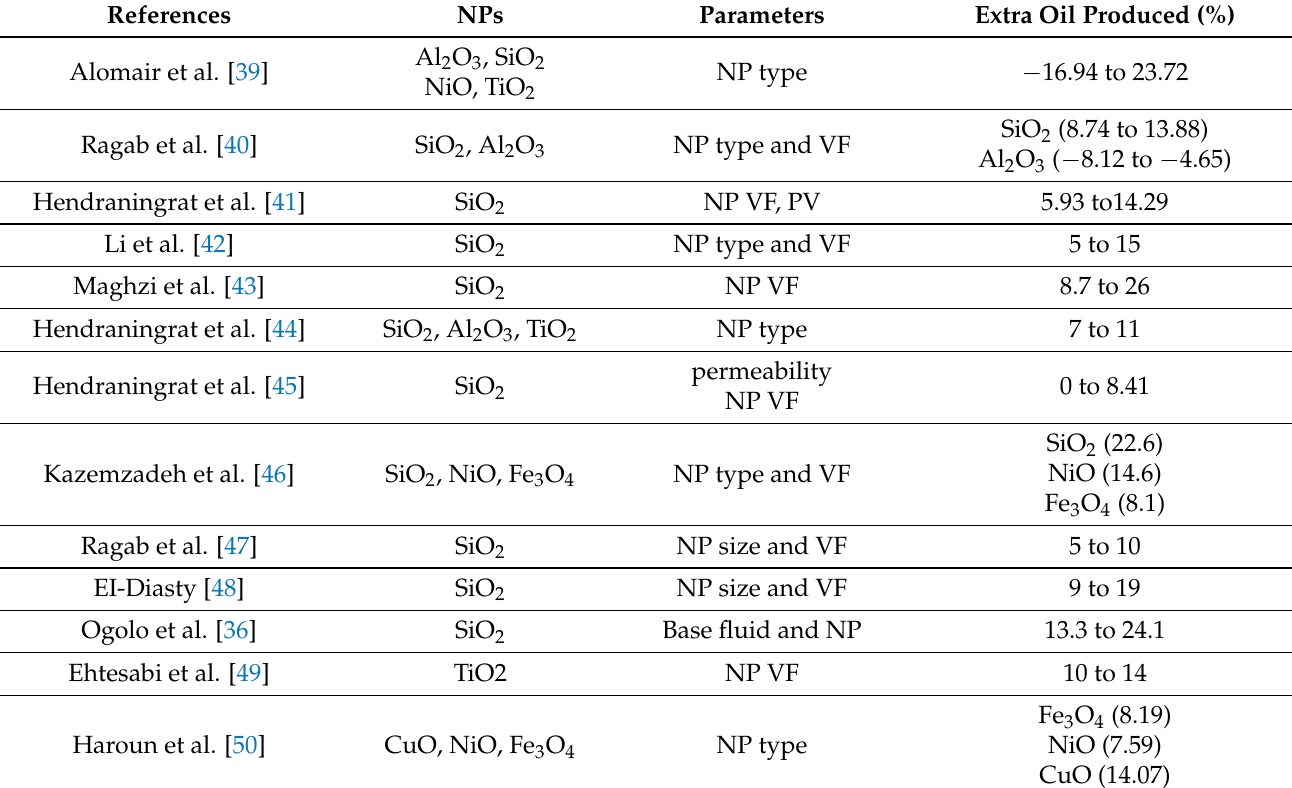
Table 1. Summary of the NF flooding experiments and